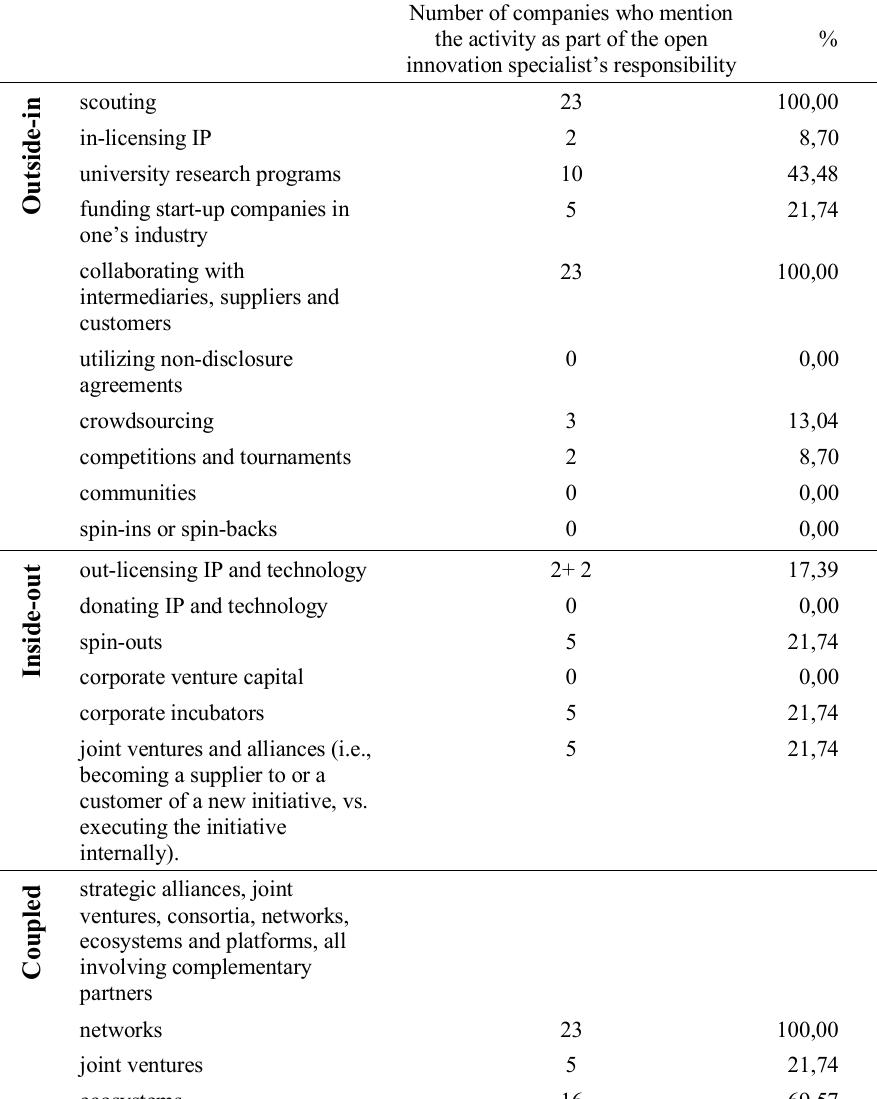
Table 1. The number of open innovation activities indicated in 23 job advertisements related to open innovation